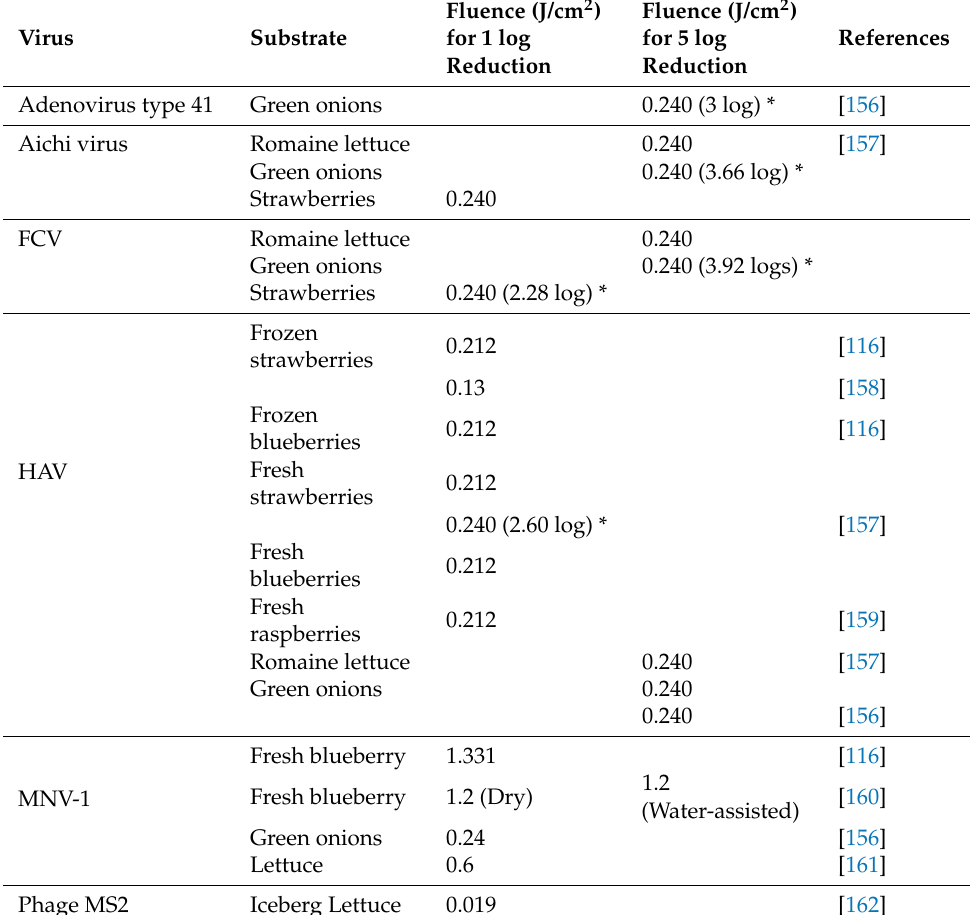
Table 2. Inactivation of viruses on fruits or vegetables by